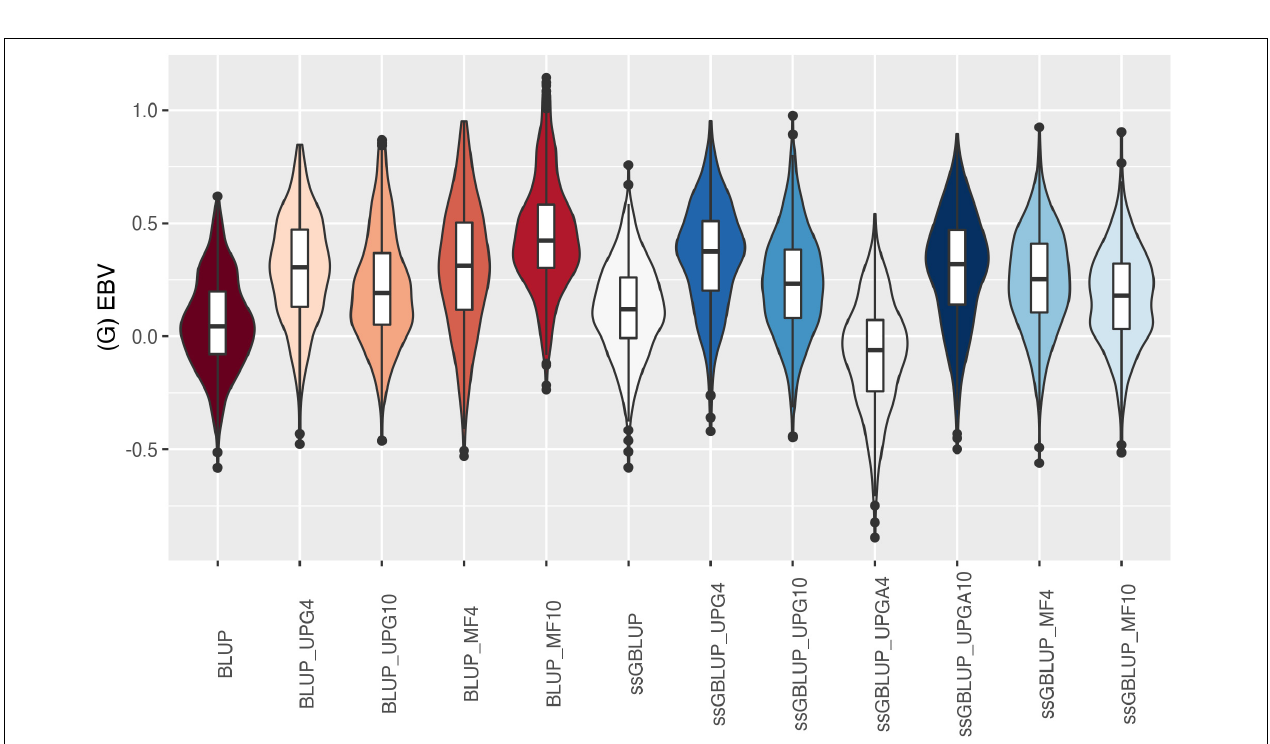
FIGURE 11 | (G)EBVs for validation animals for birth weight direct estimated using various models with and without genetic groups. (G)EBVs, (genomic) estimated breeding values.